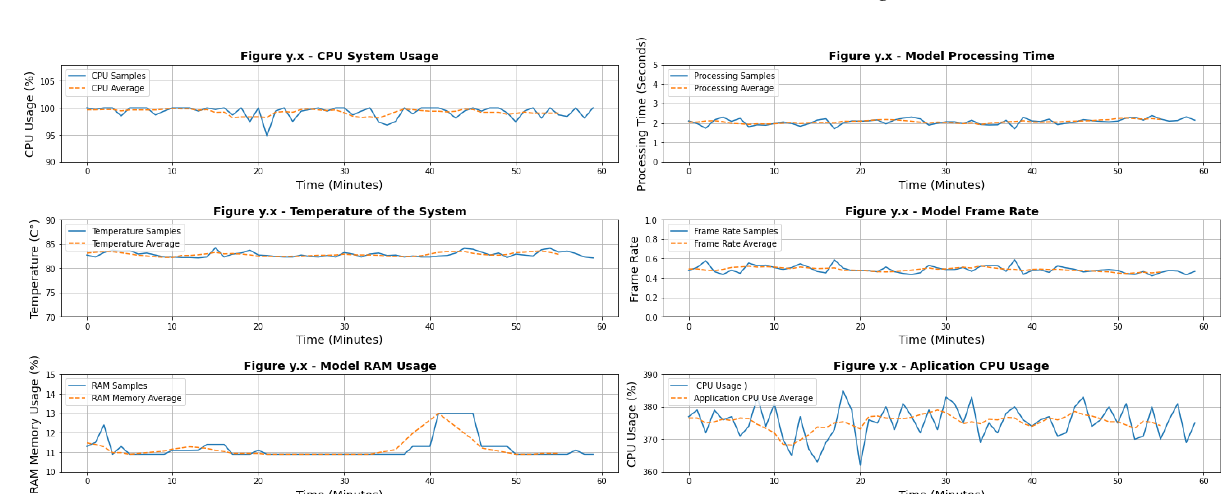
Figure 28. Benchmarking metrics captured during the tests